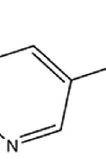
FIGURE 1 - Nicotine chemical structure (MW